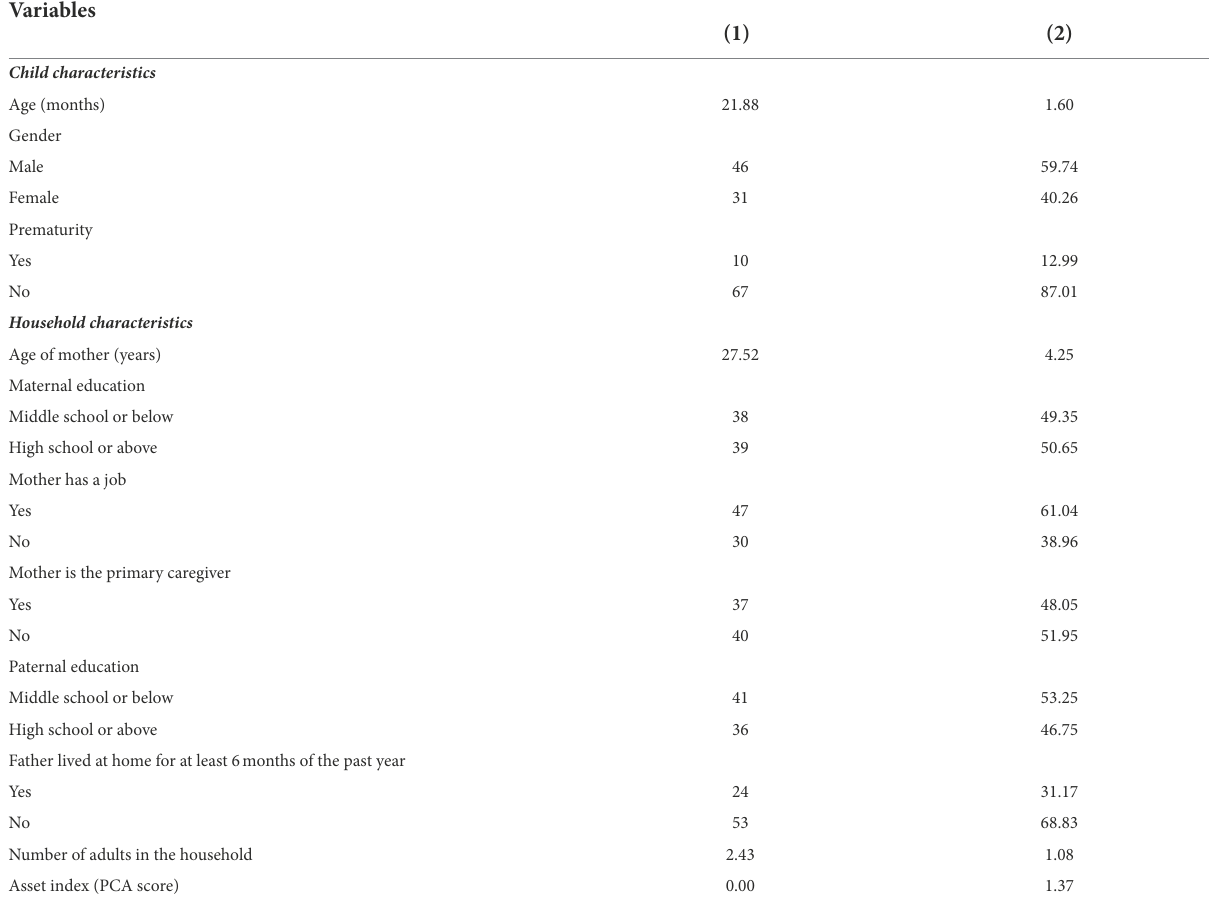
TABLE 1 Descriptive statistics of household characteristics ( N =